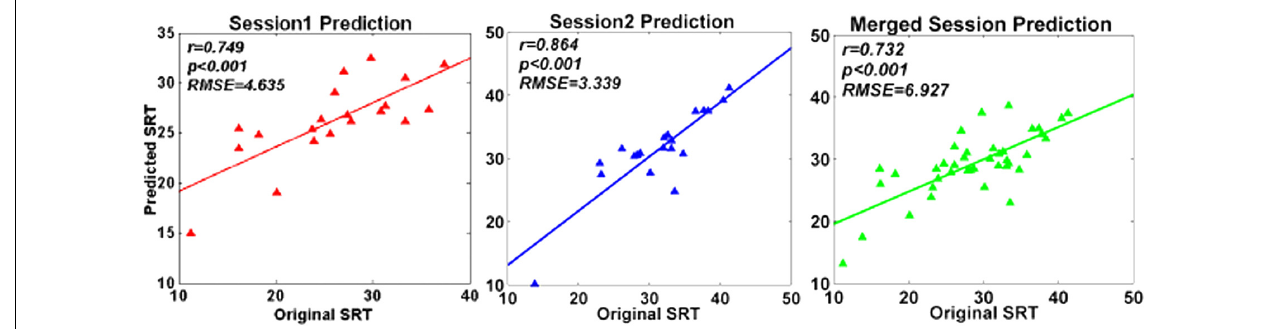
FIGURE 5 | Prediction performance of SVR model. The figures illustrated the correlations between original SRT scores and predicted SRT scores respectively in session 1, session 2, and merged